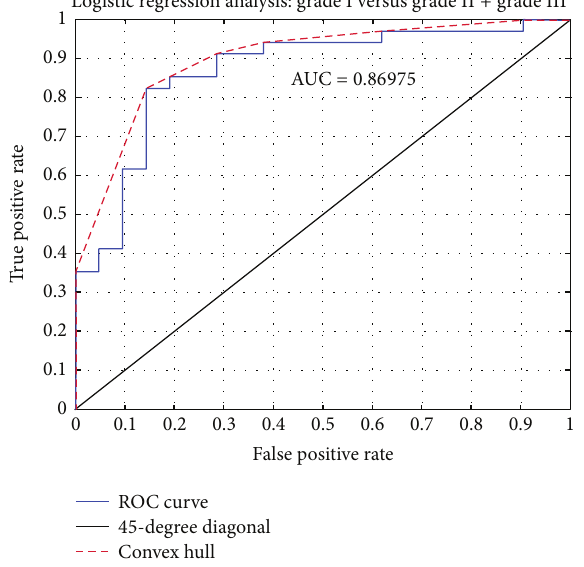
Figure4:ROCcurve:usingbestfeaturescombinationinthelogistic regression equation and the LOO cross-validation method, highest prediction accuracy was achieved (AUC = 0.87, features involved: %P63 expressed nuclei, Angular Second Moment 𝑟 , Correlation 𝑎 , Inverse Difference Moment 𝑟 , Sum Entropy 𝑟 , Solidity, and Radial Distance range). 𝑎 : average and 𝑟 : range of the feature over four directions (0 ∘ , 45 ∘ , 90 ∘ , and 135 ∘